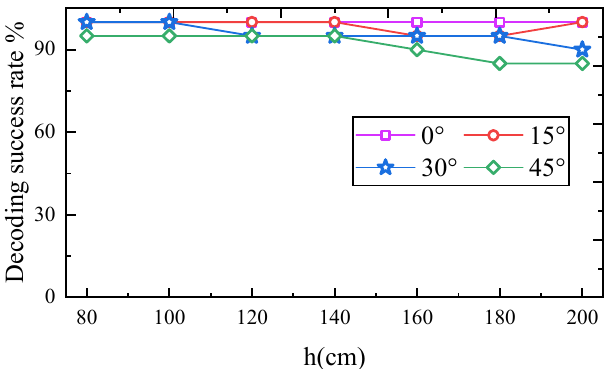
Figure 14. Decoding success rate of images from four angles at different heights.